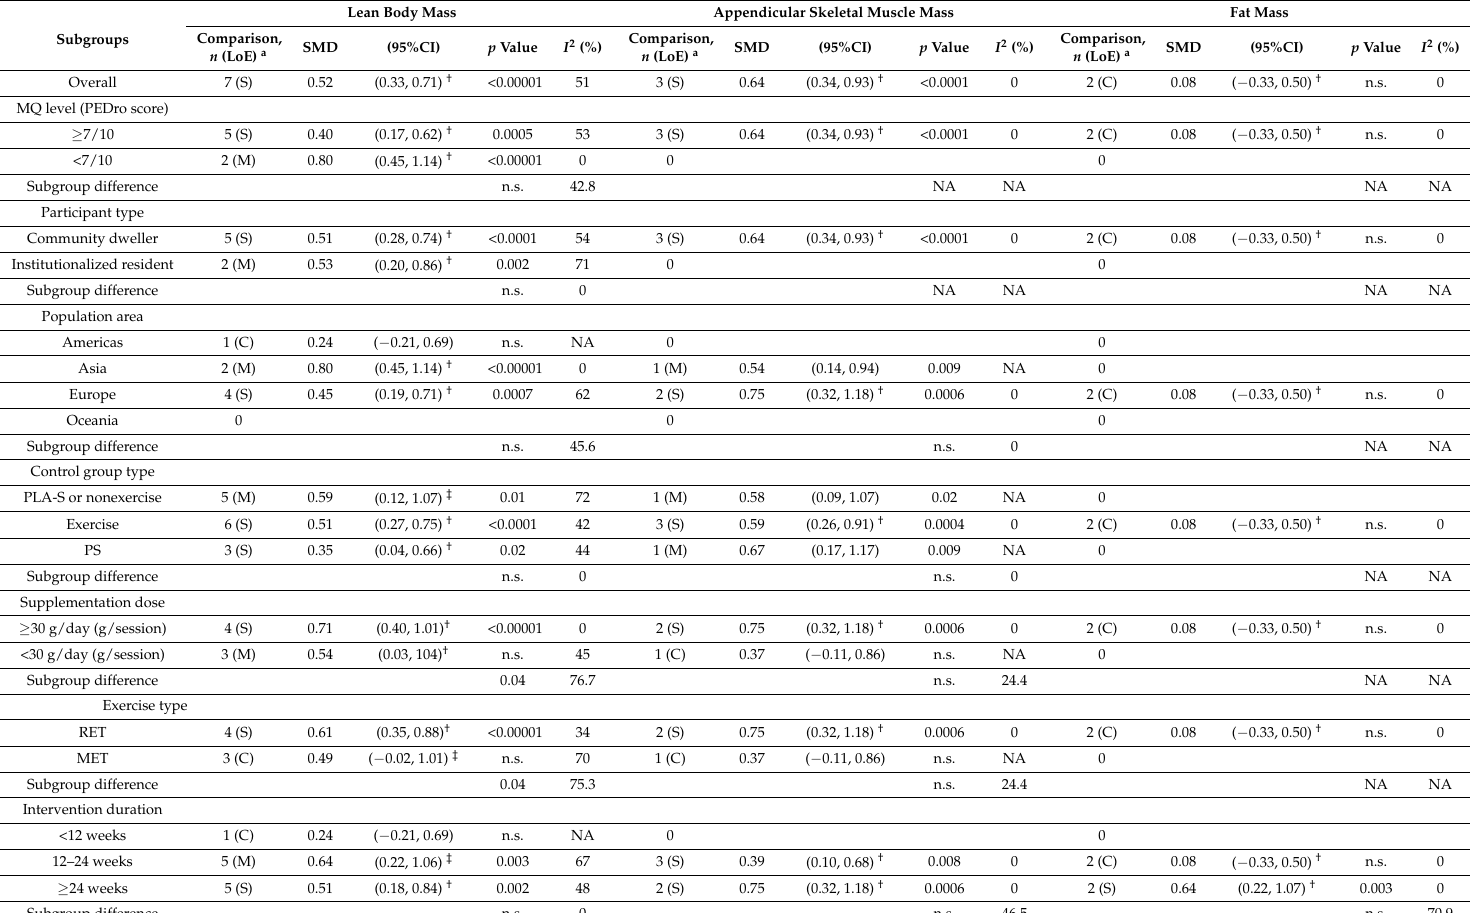
Table 4. Summary of overall effects and subgroup analysis results for body